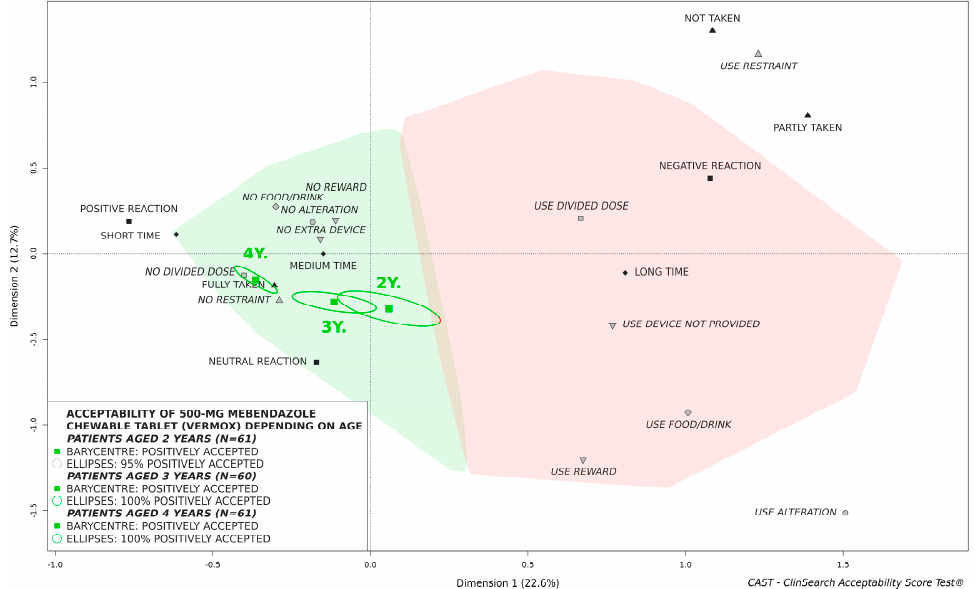
Figure 3. Influence of age on acceptability of 500-mg mebendazole chewable tablet in children aged 2 to 4 years.